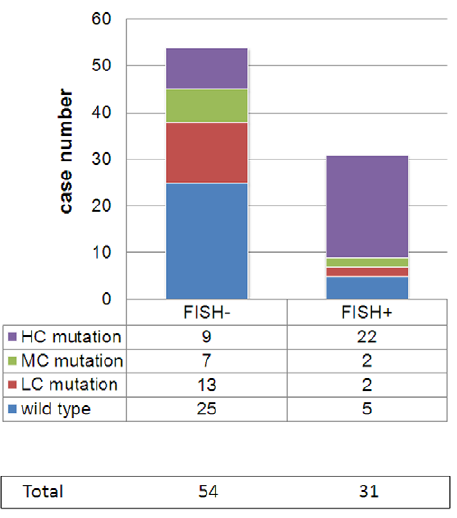
Figure 3. Extent of EGFR heterogeneity as measured by FISH. The various EGFR mutation contents are depicted in the legend.